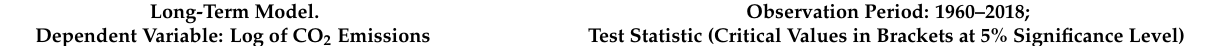
Table 5. Error correction model for CO 2 emissions: